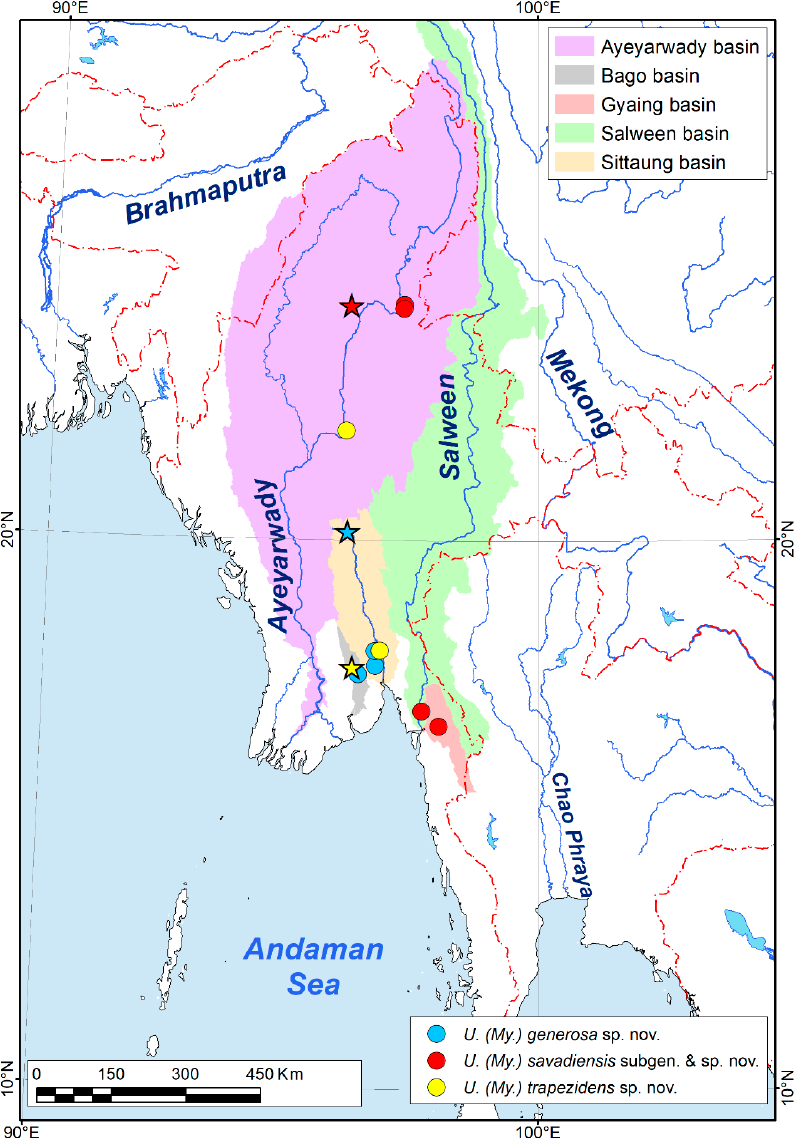
Figure 1. Type localities (stars) and additional occurrences (circles) of the new species belonging to the subgenus Myanmaratax subgen. nov. from Myanmar. (Map: Mikhail Y. Gofarov). Total DNA was extracted from whole mite specimens using a standard phenol/chlo- roform procedure [39]. The barcode region of the mitochondrial cytochrome c oxidase subunit I (COI) gene was amplified and sequenced using the LoboF and LoboR as forward and reverse primers, respectively [40]. Partial sequences of the nuclear 28S ribosomal RNA gene were amplified and sequenced using the 23F or MiF/D2 primers. The PCR mix contained approximately 100 ng of total cellular DNA, 10 pmol of each primer, 200 μ mol of each dNTP, 2.5 μ L of PCR buffer (with 20 mmol MgCl 2 ), and 0.8 units Taq DNA poly- merase (SibEnzyme Ltd., Novosibirsk, Russia). Water was added for a final volume of 25